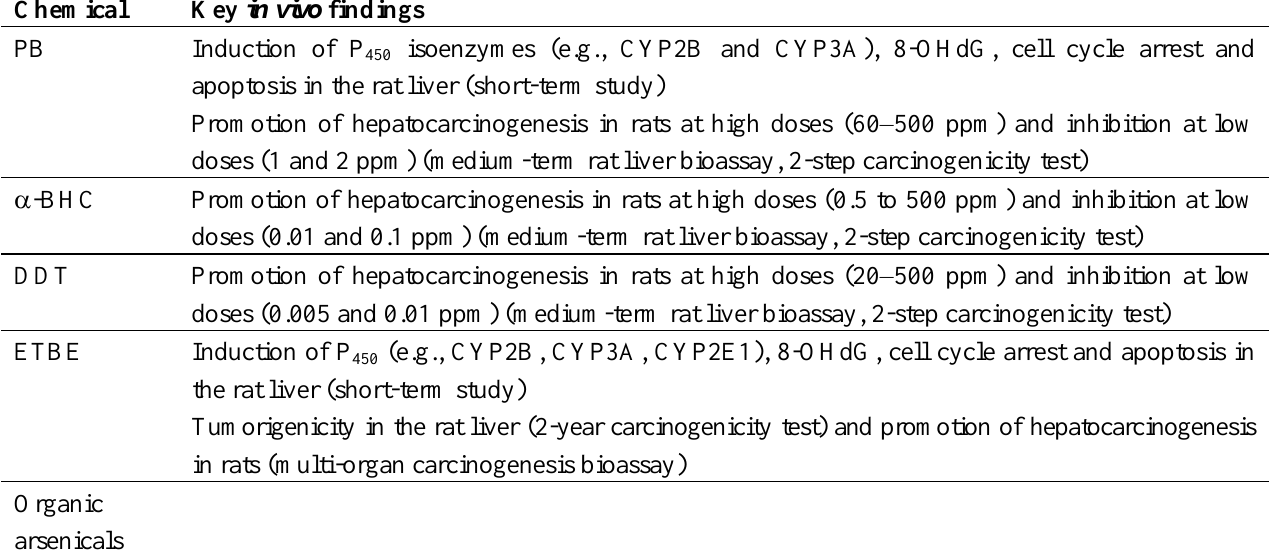
Table 1. Key in vivo findings observed with several non-genotoxic and genotoxic chemical